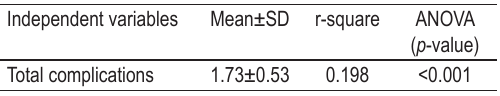
TABLE 5. Best fitting multiple regression model